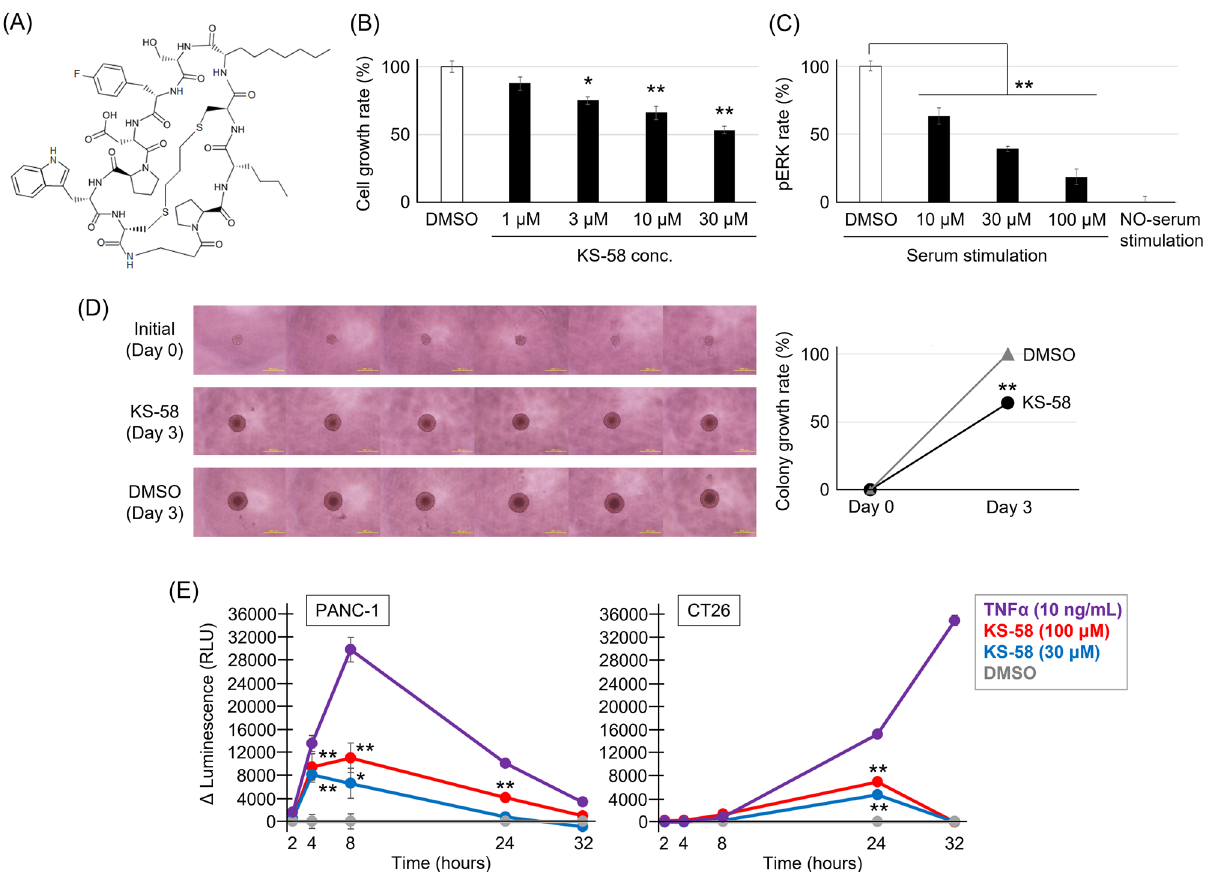
Figure 1. KS-58 suppressed in vitro proliferation of the murine colorectal cancer cell line CT26. ( A ) Chemical structure of KS-58. ( B ) Dose-dependent suppression of CT26 cell proliferation by KS-58. Results in ( B ) are expressed as mean ± S.E.M of n = 4 independent experiments using separately treated cultures (* p < 0.05 and ** p < 0.01 vs. DMSO by Dunnett’s test). ( C ) Dose-dependent suppression of phosphorylated ERK (pERK) in CT26 cells by KS-58 (n = 6, mean ± S.E.M, ** p < 0.01 vs. DMSO control by Dunnett’s test). The phosphorylation levels were shown as % value compared to DMSO set as 100% and no-serum stimulation set as 0%. ( D ) Colony growth suppression activity of KS-58 (30 μM) (yellow bar: 50 μm, n = 6, mean ± S.E.M, ** p < 0.01 vs. DMSO control by Student’s t-test). The colony growth levels were shown as % value compared to DMSO at day 3 set as 100% and initial at day 0 set as 0%. ( E ) Apoptosis inducing effect of KS-58 (30 μM and 100 μM) (n = 8, mean ± S.E.M, * p < 0.05 and ** p < 0.01 vs. DMSO by Dunnett’s test). The value on vertical axis means actual values minus average value of DMSO